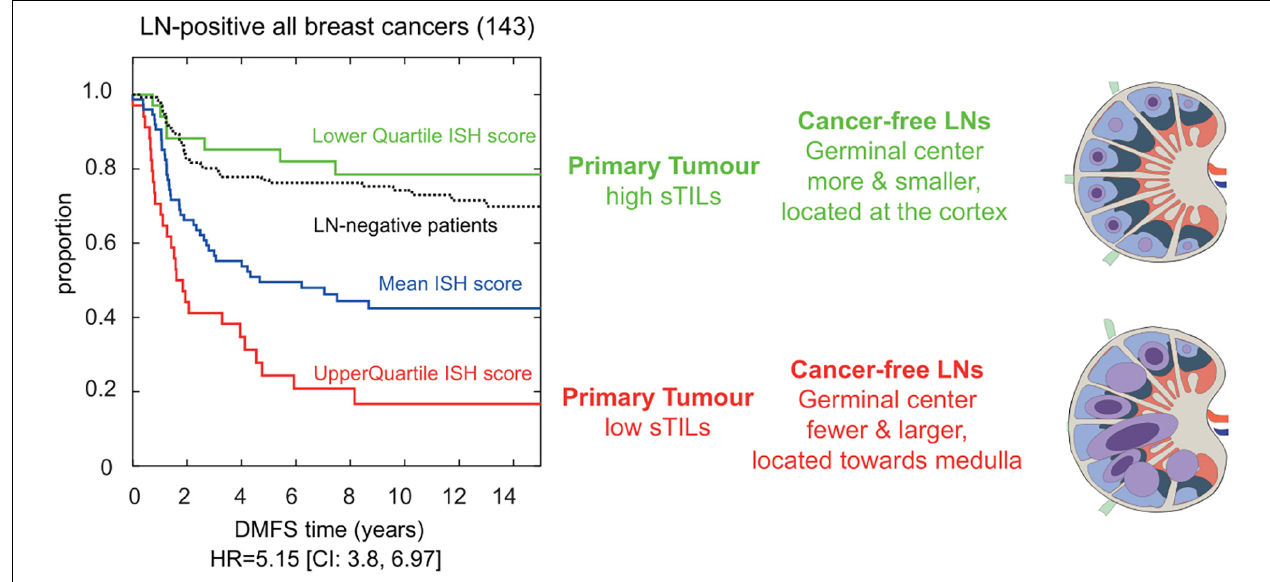
FIGURE 1 | Immune-stroma-histological (ISH) score is risk-predictive of developing distant metastasis in breast cancer patients. Cox proportional hazards regression analysis of LN-positive breast cancer patients (n:143) separated based on their immune and stromal histomorphological features. We developed an ISH-risk score capturing several different immune and stromal features at the primary tumor side, in cancer-free and metastatic lymph nodes. Patients with high scores had shorter time to distant metastasis (red line in Kaplan–Meier graph). Their cancer-free LNs had fewer and larger germinal centers (GCs; blue circles) located toward the center of the node. Cancer-free LN with smaller and more GCs were (blue circles) found in patients with longer time to metastasis (green line in Kaplan–Meier graph). These patients had a better prognosis than LN-negative patients (black lines in Kaplan–Meier). Hazard ratio (HR) and confidence interval (CI) are shown below the graph, modified from Grigoriadis et al.